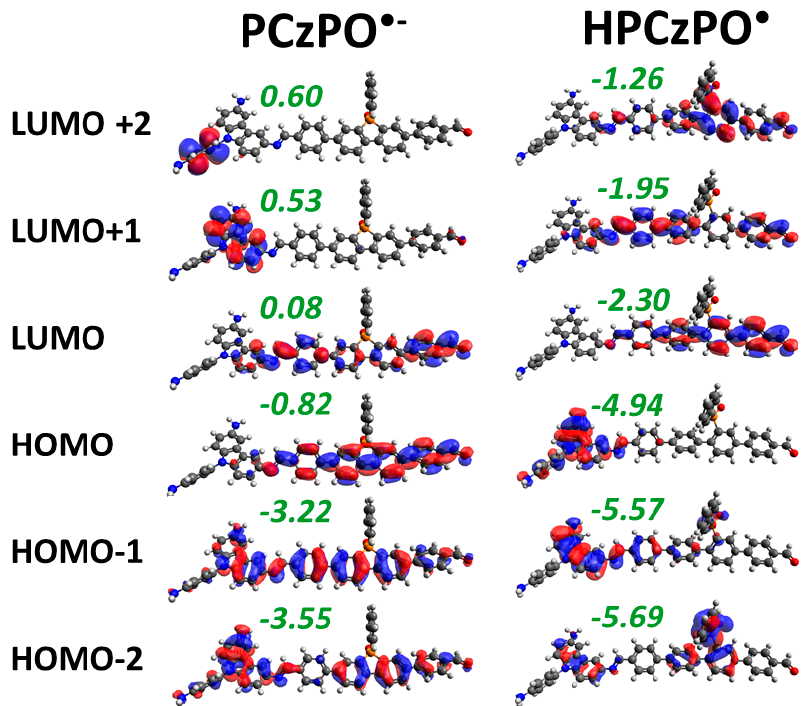
Figure 4. 3D electron density distribution of the frontier orbitals of PCzPO •- and H-PCzPO • calculated under DFT-B3LYP/6-311G(d,p) level of theory.